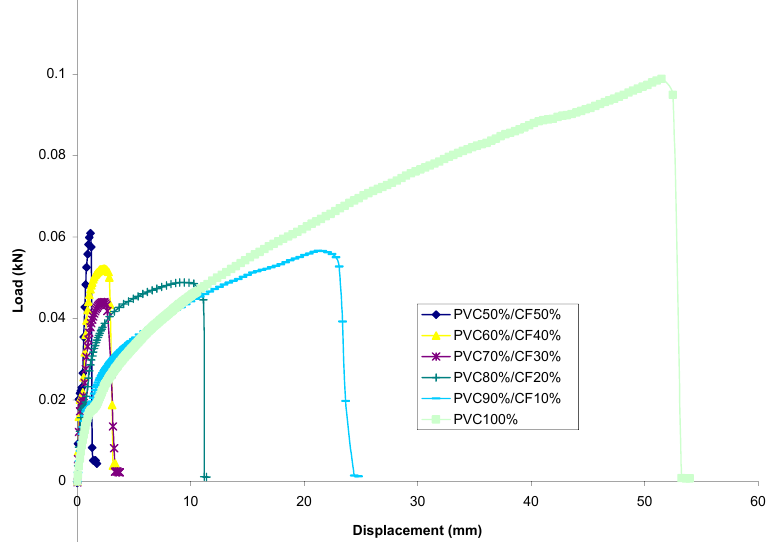
Figure 7. Load versus displacement for averaged curve of cotton fiber reinforced PVC